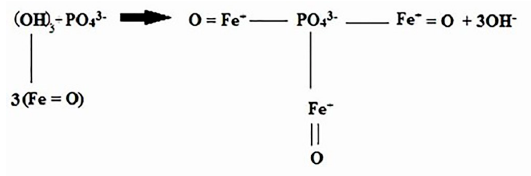
Figure 1. Mechanism of phosphorus occurrence in goethite.